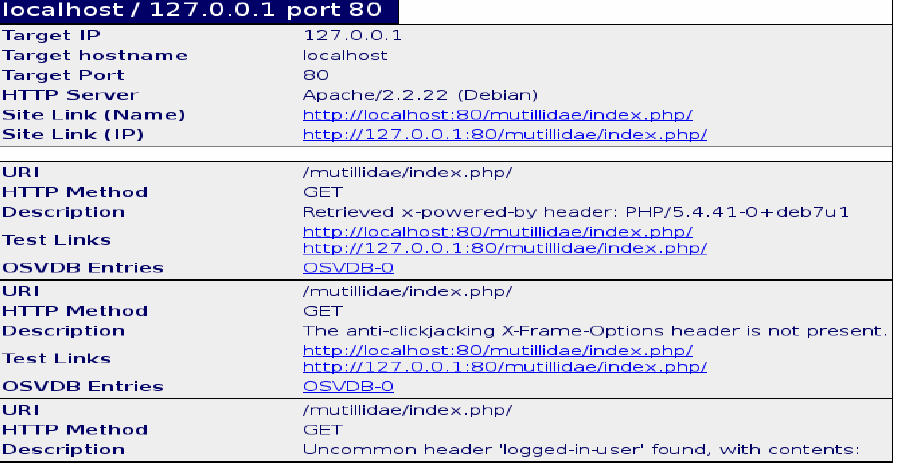
Figure 12 – Nikto – presentation of the report in the Iceweasel browser Рис . 12 – Nikto – отчет в браузере